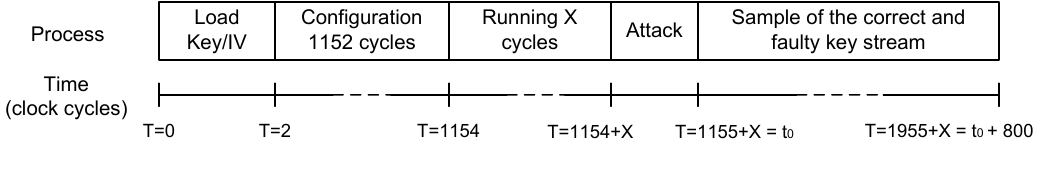
Figure 3. Representation of the attack and acquisition